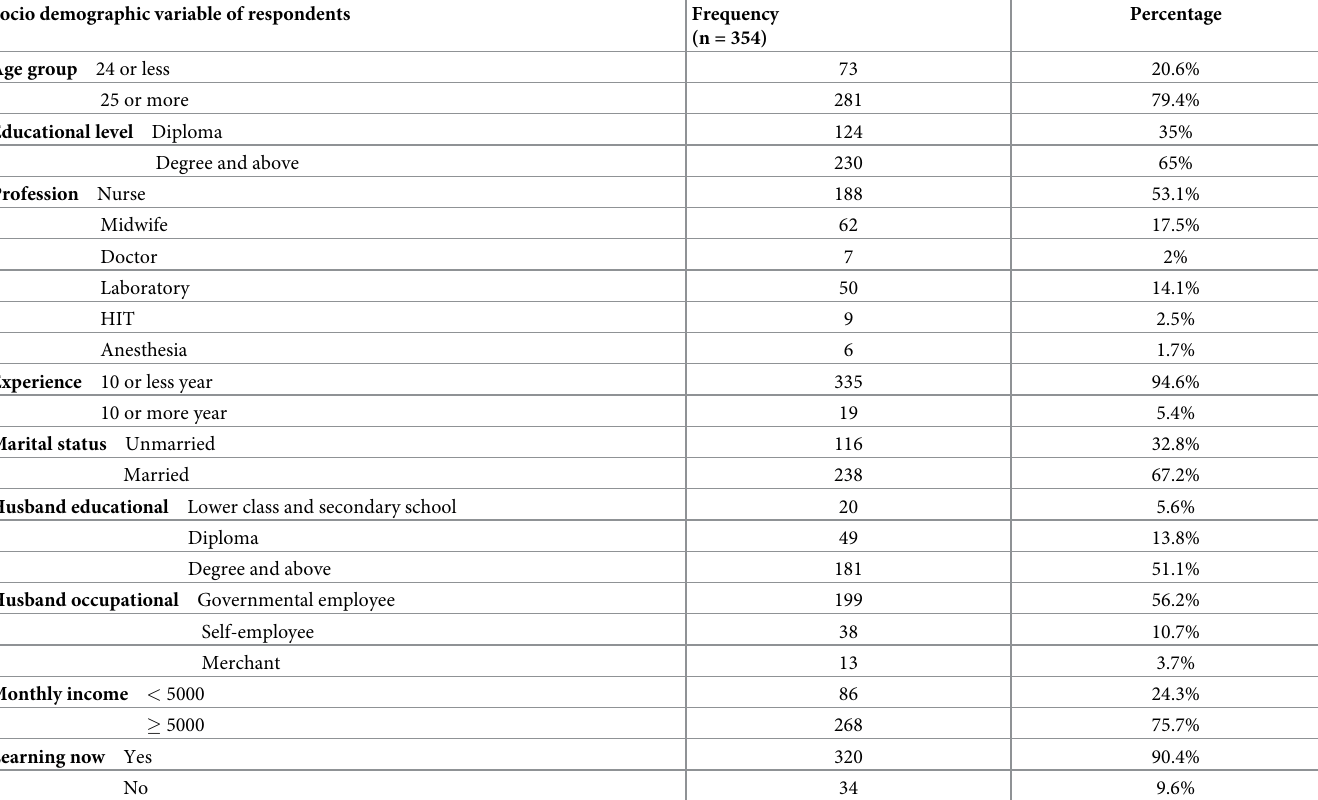
Table 2. Socio-demographic characteristic for factor associated with utilization of LACMs service in south wollo zone hospitals, 2021. N = 354. Socio demographic variable of